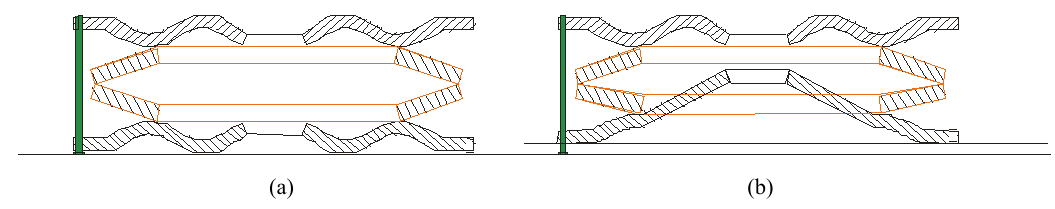
Fig. 13. Behavior of the deformable component: (a) before test, (b) after test